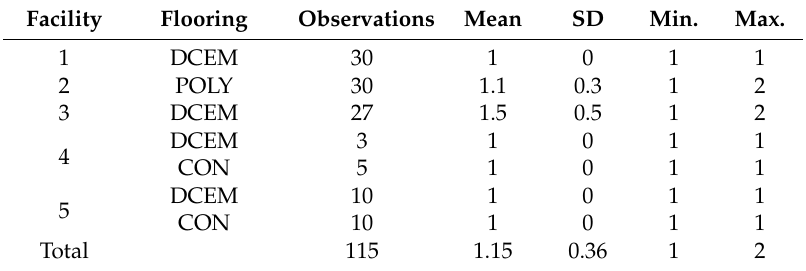
Table 6. Visual Kennel Cleanliness Scores. Summary of the results of the cleanliness scoring by facility and floor type. DCEM = Diamond-shaped coated expanded metal, POLY = Polypropylene and CON = Concrete.